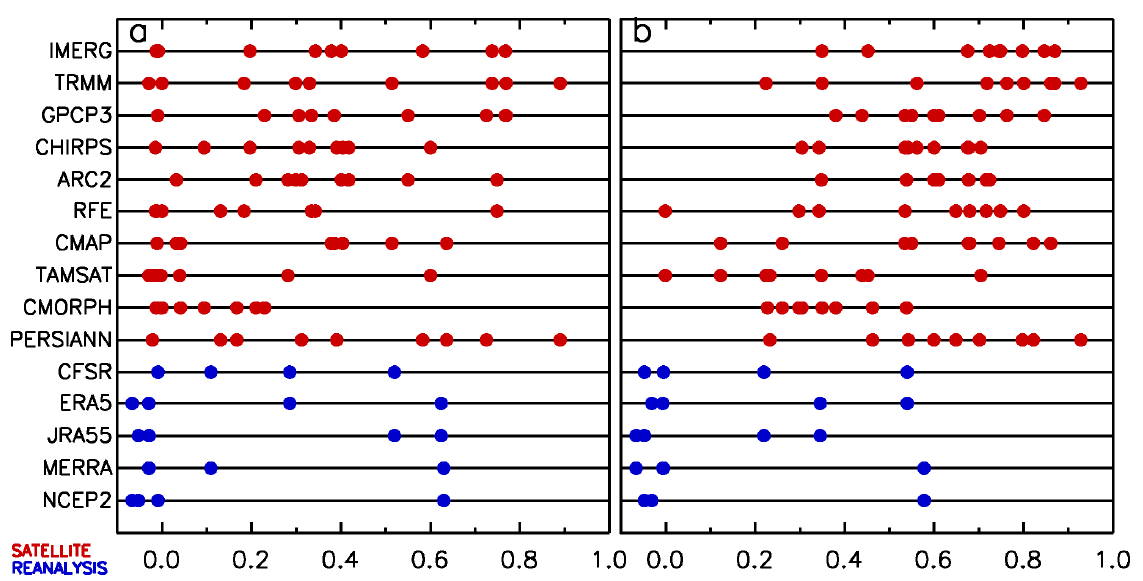
Figure 13. Correlation among rainfall products over the Congo: Each satellite product is correlated with all other satellite products, with the correlation values indicated on the x -axis (red values). Each reanalysis rainfall product is correlated with every other reanalysis product (blue values). Annual rainfall correlations are on the left ( a ). November rainfall correlations are on the right ( b ). The 10% significance level is 0.37 and the 5% significance level is